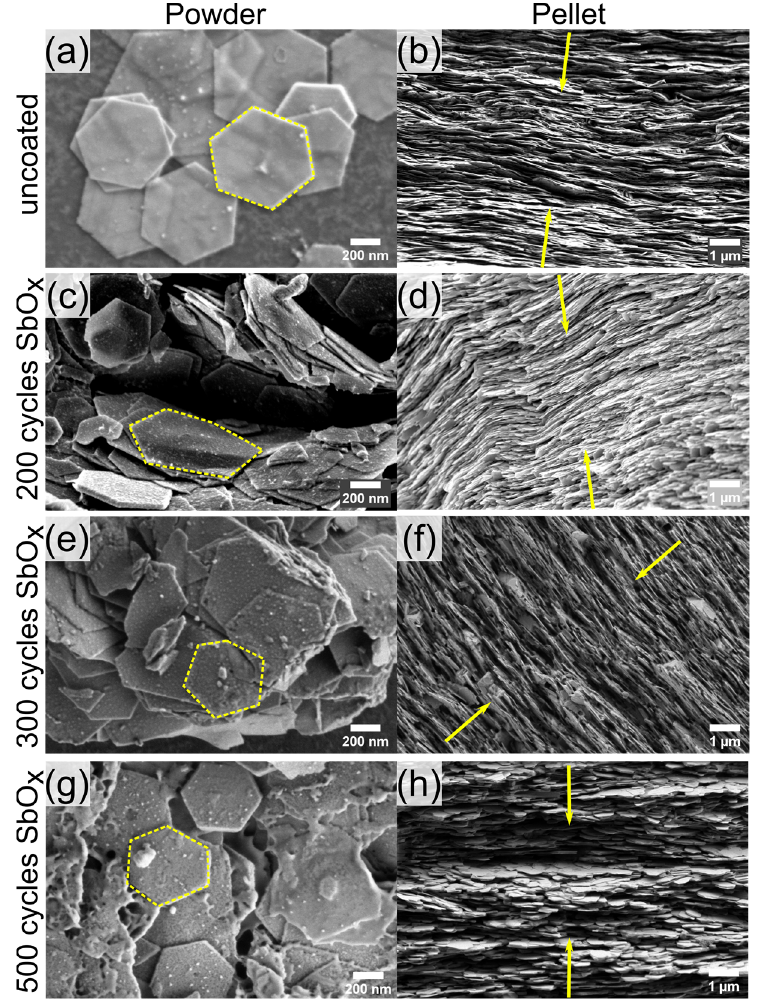
Figure 3. SEM images of ( a ) solvothermally synthesized Bi 2 Te 3 particles, ( b ) cross-section of sintered pellet, ( c ) Bi 2 Te 3 particles SbO x -coated for 200 cycles and ( d ) cross-section of sintered pellet, ( e ) Bi 2 Te 3 particles SbO x -coated for 300 cycles and ( f ) cross-section of sintered pellet, ( g ) Bi 2 Te 3 particles SbO x -coated for 500 cycles and ( h ) cross-section of sintered pellet. The arrows indicate the pressing